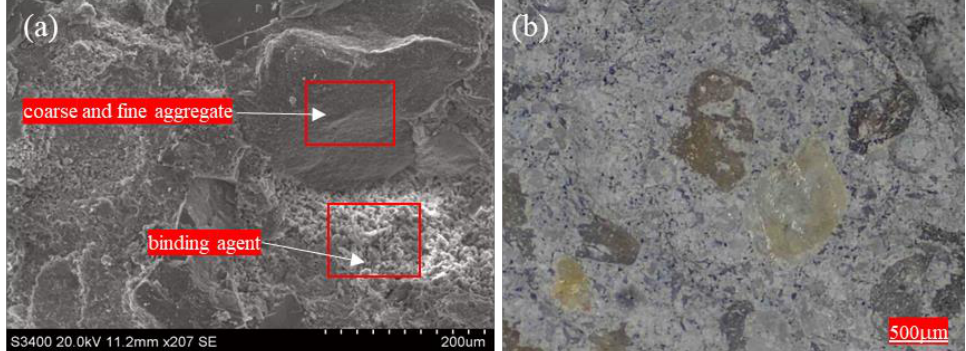
Figure 10. Microstructure of rock materials: ( a ) scanning electron microscope (SEM) image; ( b ) cross-section light microscope image.